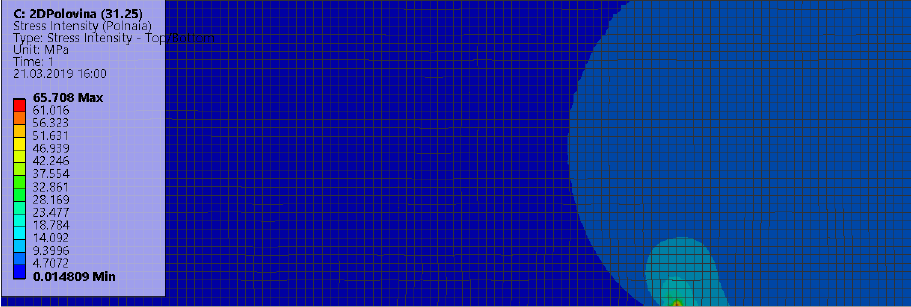
Fig. 11. Distribution of stress intensity σ i in the lower part of the deep